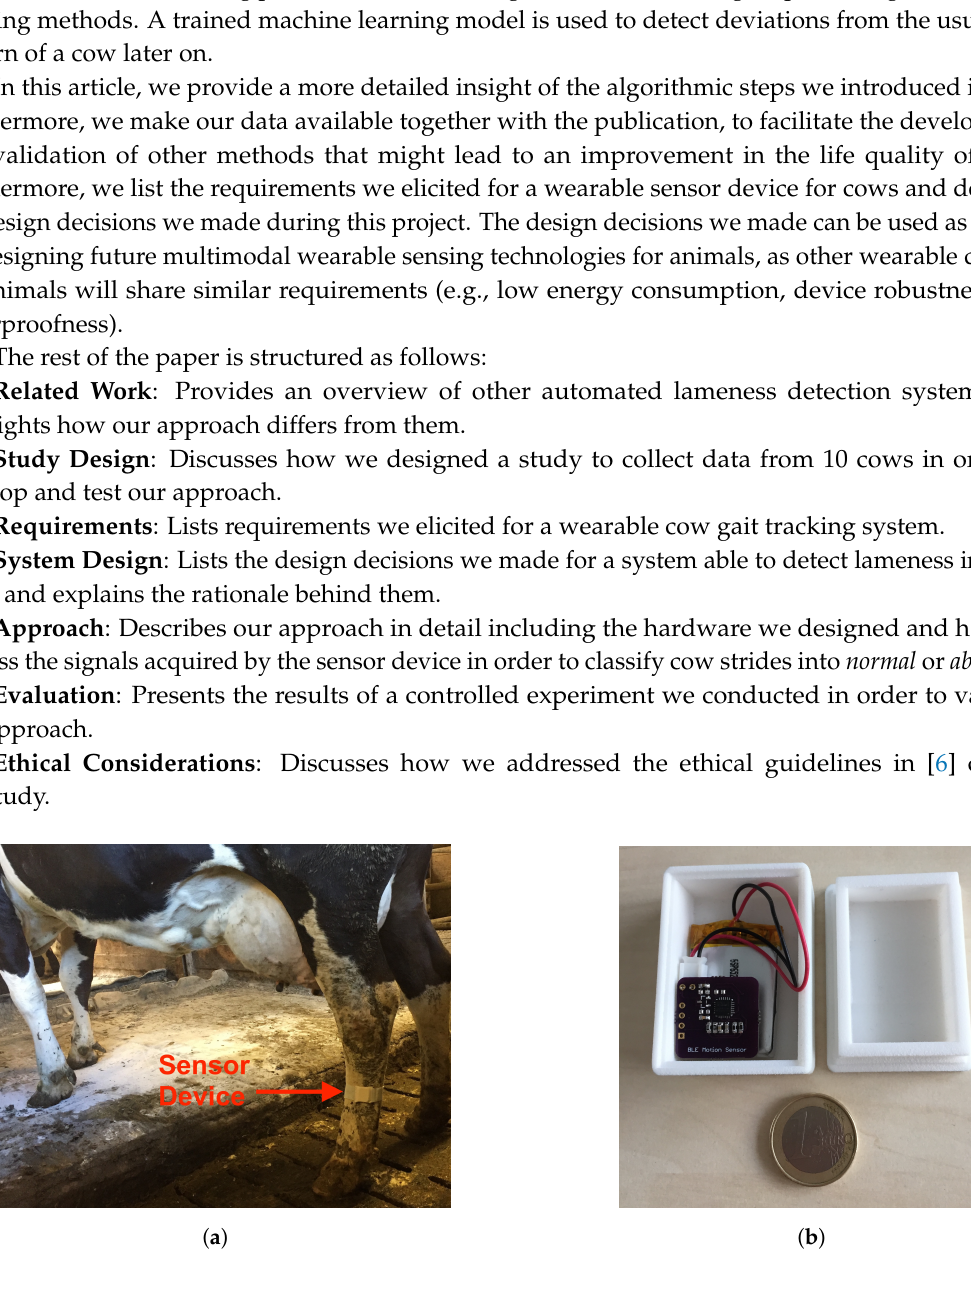
Figure 1. Motion sensor attached to a cow’s hind left leg taken from [4,5] ( a ) and sensor box ( b